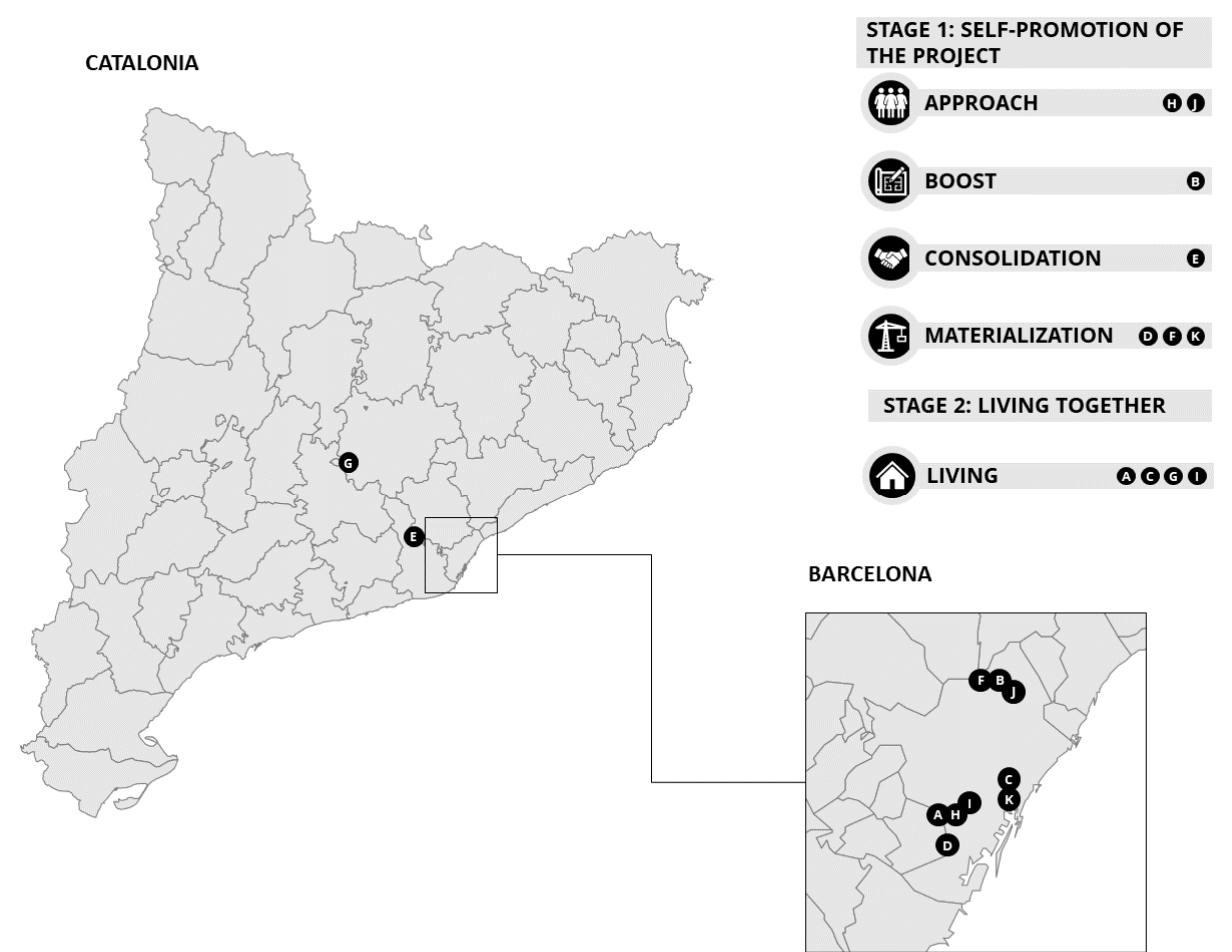
Figure 2. Cooperative housing under the GoU model in Catalonia and Barcelona.